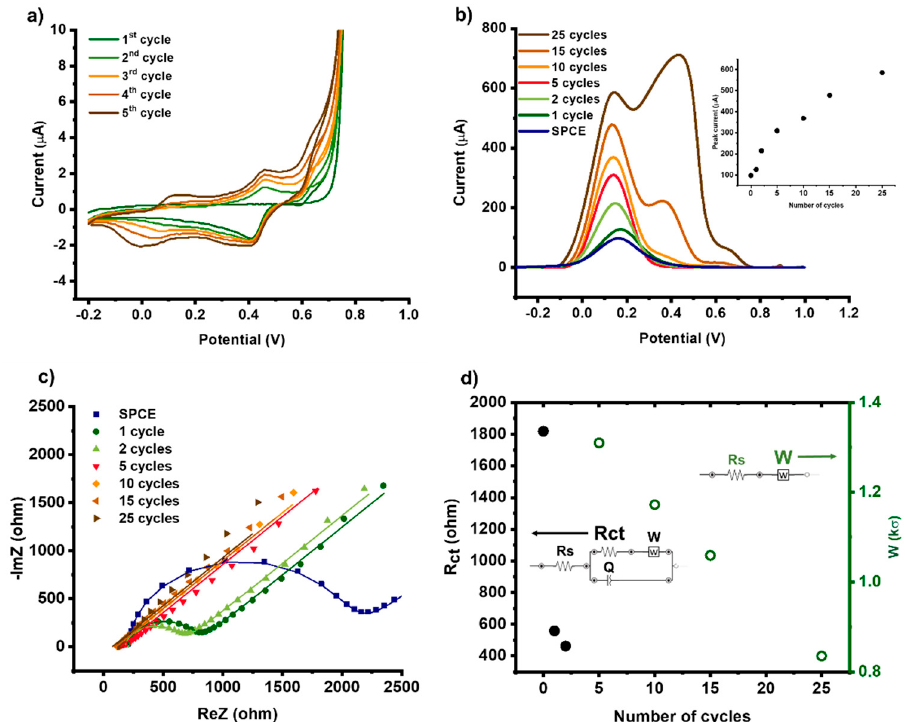
Figure 1. Five cyclic voltammograms (CVs) during electrodeposition of PANI recorded in 0.5 M HCl with 0.1 M aniline ( a ). Square-wave voltammograms ( b ) and electrochemical impedance spectra (EIS: symbols for measurements, lines for fitted data) ( c ) recorded in 0.1 M KCl with 1.0 mM [Fe(CN) 6 ] 3 − /4 − using SPCEs modified with a different number of PANI electrodeposition cycles. Decrease in charge-transfer resistance ( R ct ) for zero, one, and two cycles of PANI electrodeposition (black symbols, left Y axis) obtained by fitting raw impedance data using the Randles circuit (inset), and the decrease in Warburg constant phase element ( W ) for a higher number of PANI electrodeposition cycles (white-green symbols, right Y axis) obtained by fitting raw impedance data using the simpler equivalent circuit, i.e., R s -W (inset) ( d ).